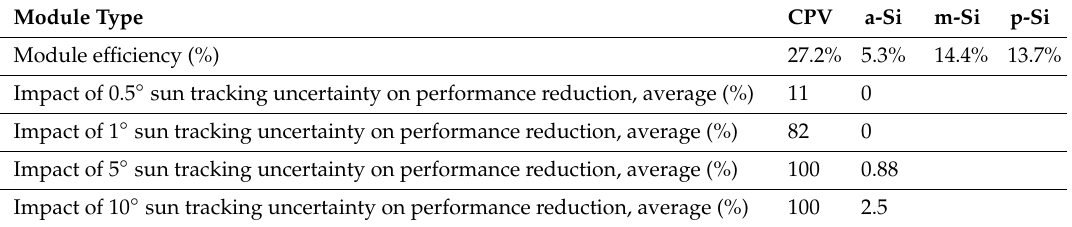
Table 2. The e ffi ciency of CPV a-Si, m-Si, and p-Si PV modules and the average impact of sun tracking uncertainties of 0.5 ◦ , 1 ◦ , 5 ◦ , and 10 ◦ on the performance of these modules (values for a-Si, m-Si, and p-Si taken from